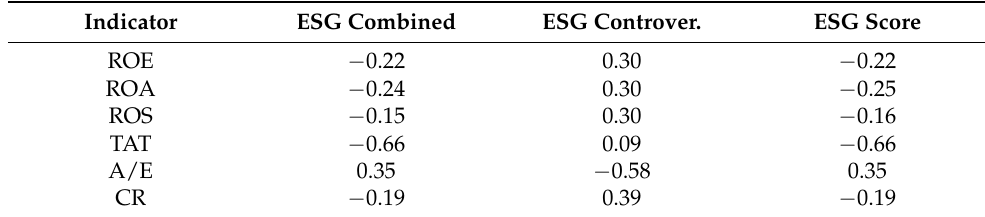
Table 6. Correlations between values of indicators taken into account in research in the case of the enterprise PGE Polska Grupa Energetyczna S.A. (period of 2010–2019). Indicator ESG Combined ESG Controver. ESG Score ROE − 0.22 0.30 − 0.22 ROA − 0.24 0.30 − 0.25 ROS − 0.15 0.30 − 0.16 TAT − 0.66 0.09 − 0.66 A/E 0.35 − 0.58 0.35 CR − 0.19 0.39 − 0.19